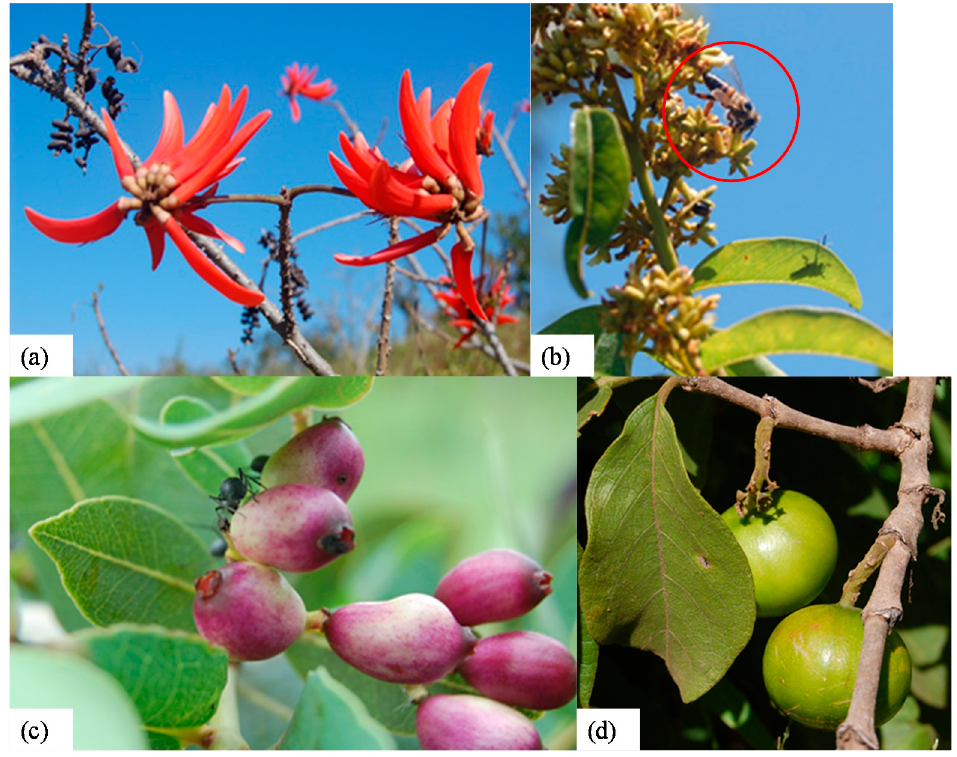
Figure 4. Flowering, pollination and fruiting in the three- and five-year-old habitats. ( a ) Erythrina lysistemon with flowers and pods; ( b ) bee pollination (within the red circle) on a Dalbergia obovata flower; ( c ) Syzygium cordatum fruits; and ( d ) Vangueria infausta fruits.